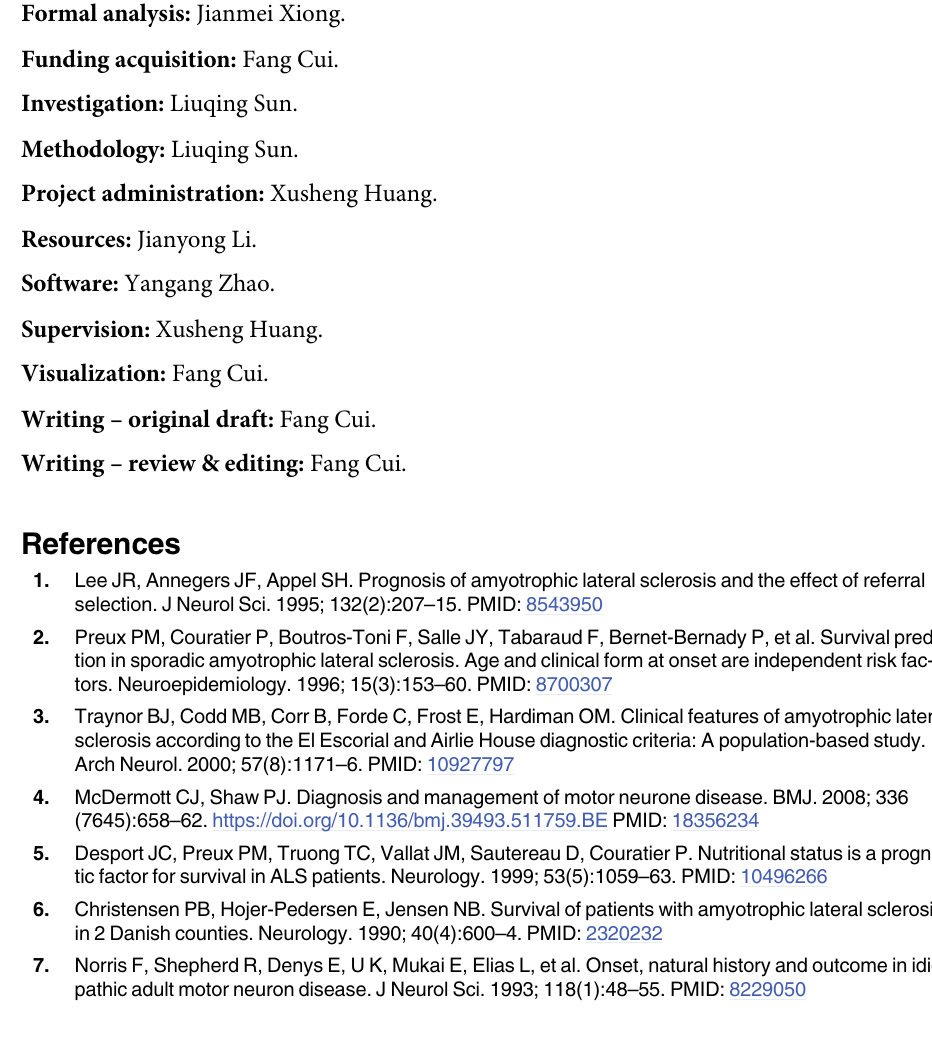
S1 Table. Meta-regression for investigated outcomes according to sample size, mean age, and percentage